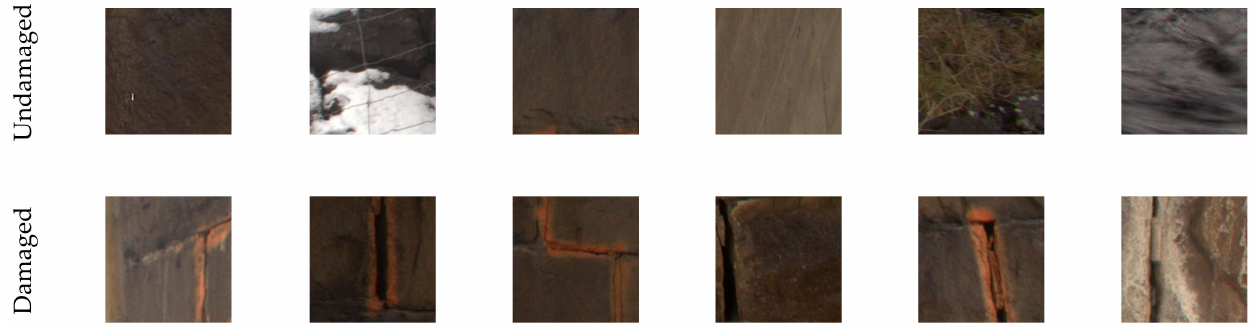
Figure 7. Examples of the prepared dataset for detection of potentially damaged areas.